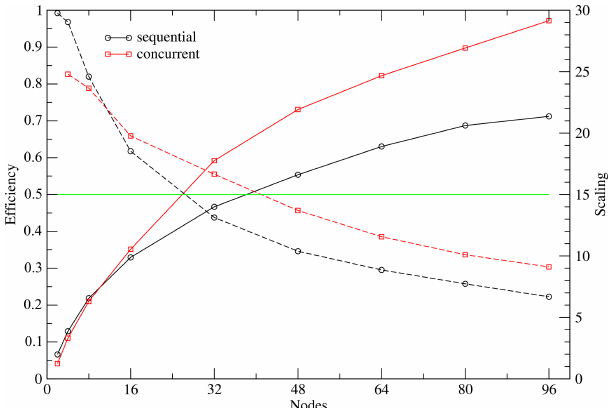
Figure 10. Scaling (solid line) and parallel efficiency (dashed line) for the 160km sequential and concurrent setups. The 0.5 efficiency line is